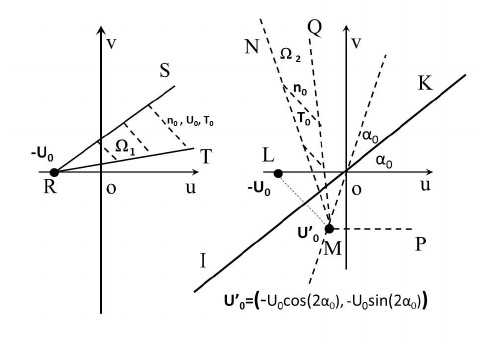
Figure 4. Velocity space for jet impinging on a specular planar reflective plate. (cid:54) TRu = θ 1 , (cid:54) SRu = θ 2 , Ω Ω (cid:54) QMP = θ (cid:54) NMP = θ 5 , 6 . Integration domain, 2 is for the reflected 1 is for the free jet, and